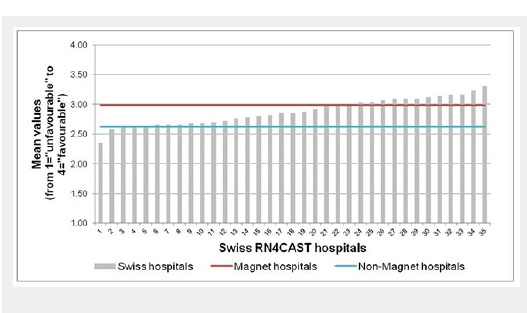
Variability in the quality of the nurse work environment (PES-NWI composite score) in our sample, compared to international